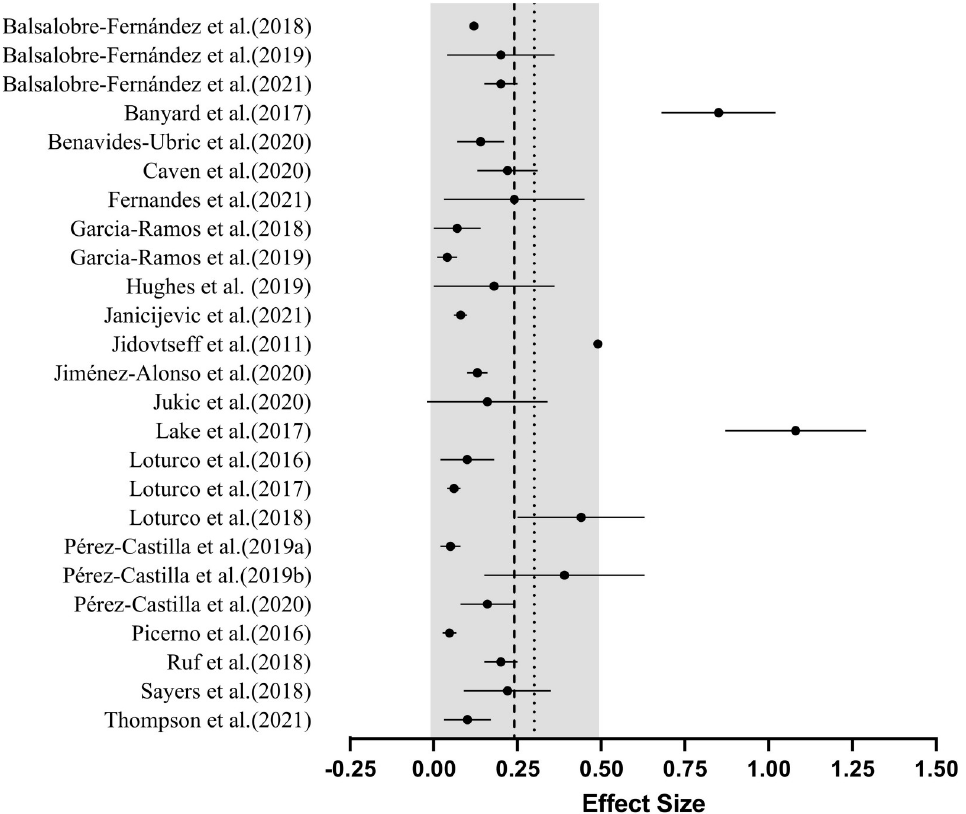
Fig 2. Overall mean ( ● ) effect sizes ( ± SD), grouped average (---) and recommended maximum effect size ( ��� ) lifor magnitude of difference between predicted and actual 1RM. The grey band represents the standard deviation of the pooled effect sizes. Note : Effect sizes closer to zero indicate greater validity (i.e., smaller difference between actual and predicted 1RM).